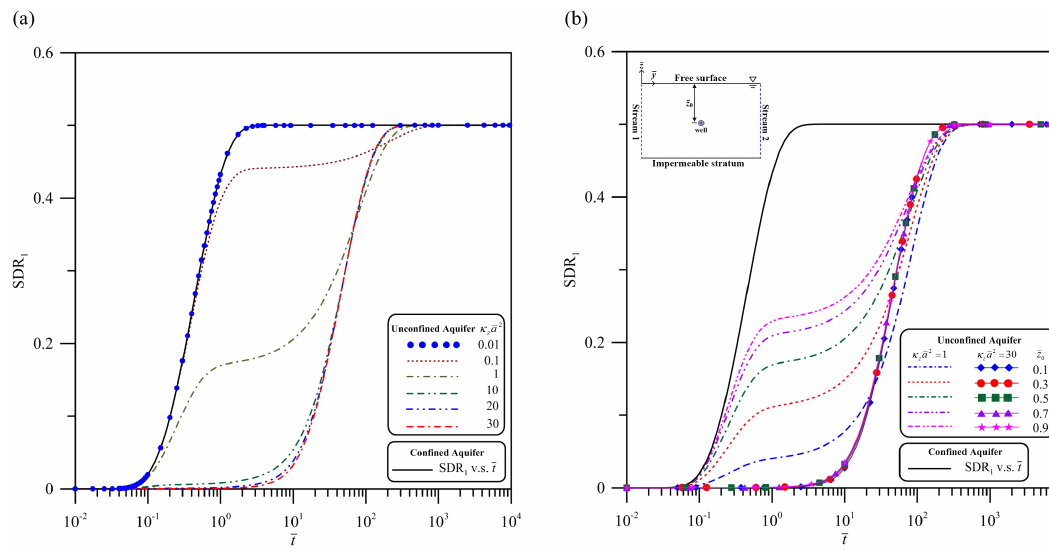
Figure 5. Temporal SDR 1 distributions predicted by Eq. (52) for stream 1 with various values of (a) κ z a 2 and (b) z 0